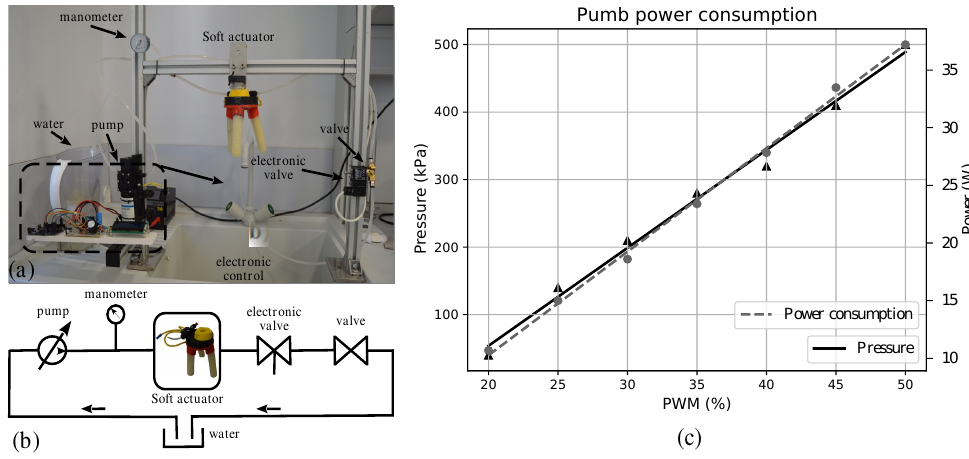
Figure 9. ( a ) Hydraulic system for controlling and acting the soft gripper, ( b ) hydraulic scheme, and ( c ) pump consumption under different operating